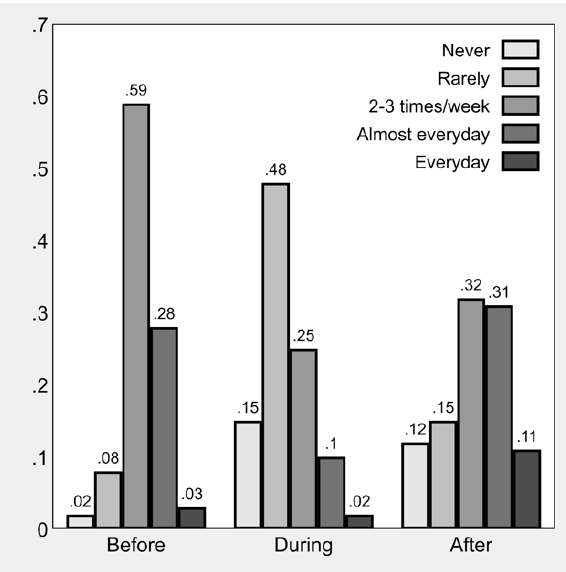
Figure 1. Frequency of child sport participation before, during, and after Italy’s national lockdown ( n = 1134).